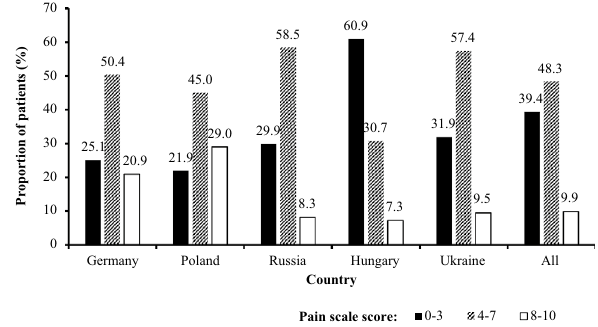
Figure 3. Patient self-reported pain as assessed by numeric scale where 0 ‒ 3 indicates mild pain, 4 ‒ 7 indicates moderate pain, and 8 ‒ 10 indicates severe pain. Patients from Switzerland are not presented here as a subcategory owing to low patient numbers ( n = 74).